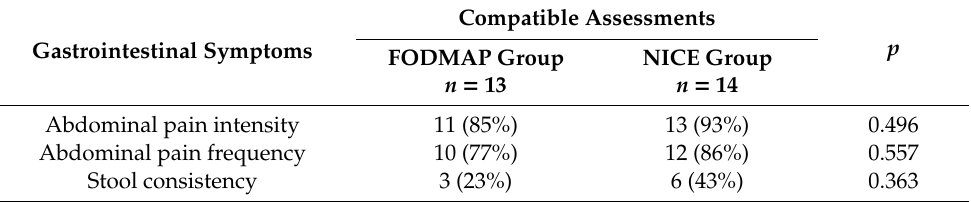
Table 2. The assessment of the agreement of symptom perception between parents and children during dietary intervention.